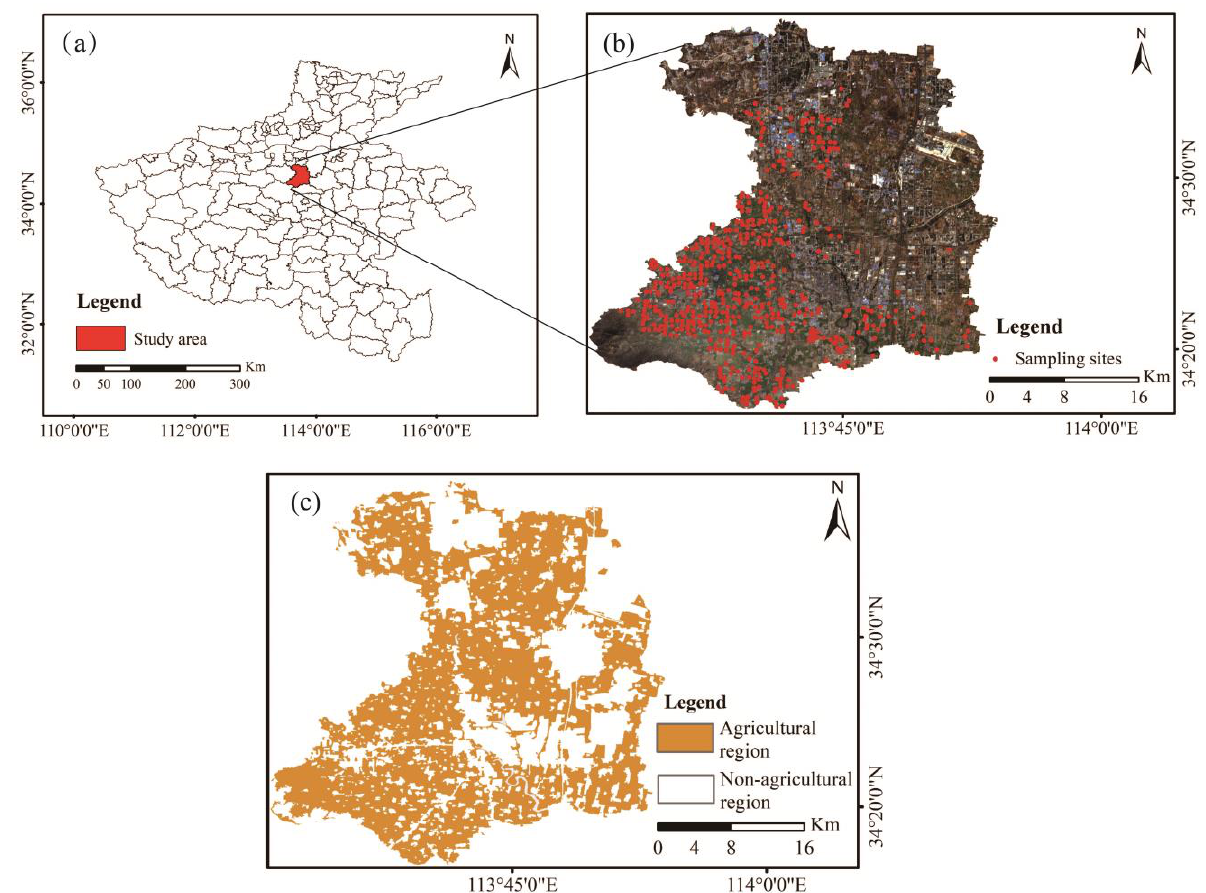
Figure 1. Map of the study area (( a ): map of Henan Province; ( b ) ZY1-O2D hyperspectral image and location of the study area ’ s sampling locations; ( c ) the study area ’ s distribution of agricultural areas).